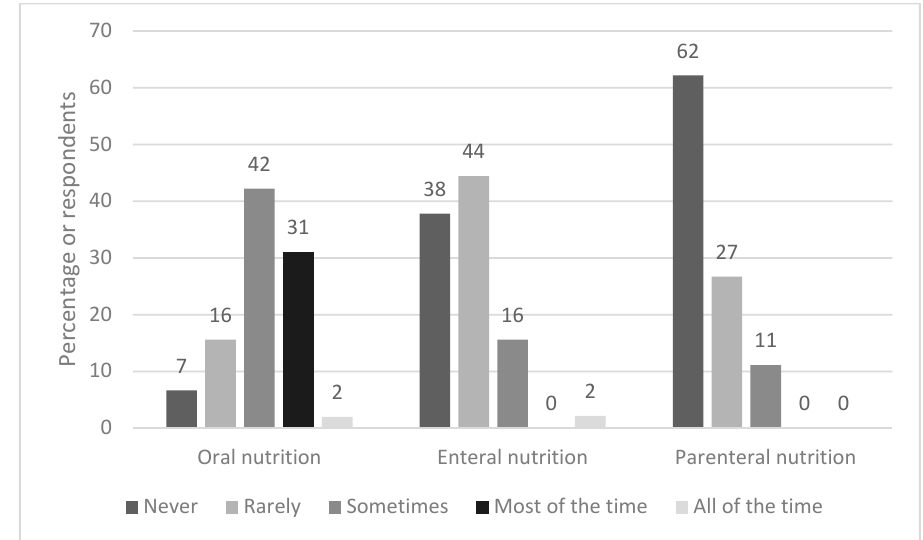
Figure 2. Frequency and type of nutrition support used. Table 2. Themes from responses to question: ‘What would help optimise the referral rate and dietetic management of pregnancies with HG?’